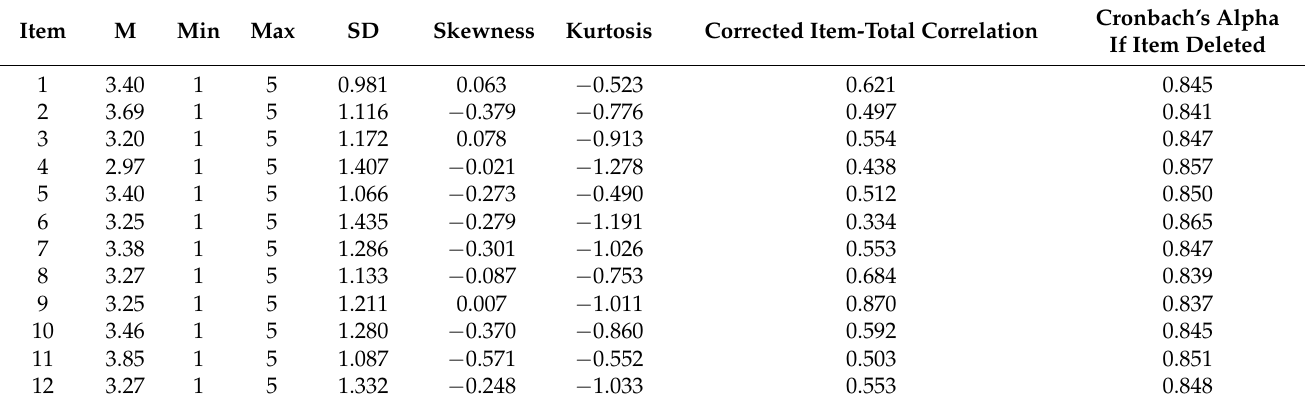
Table 2. Descriptive statistics of the FoP-Q-SF.